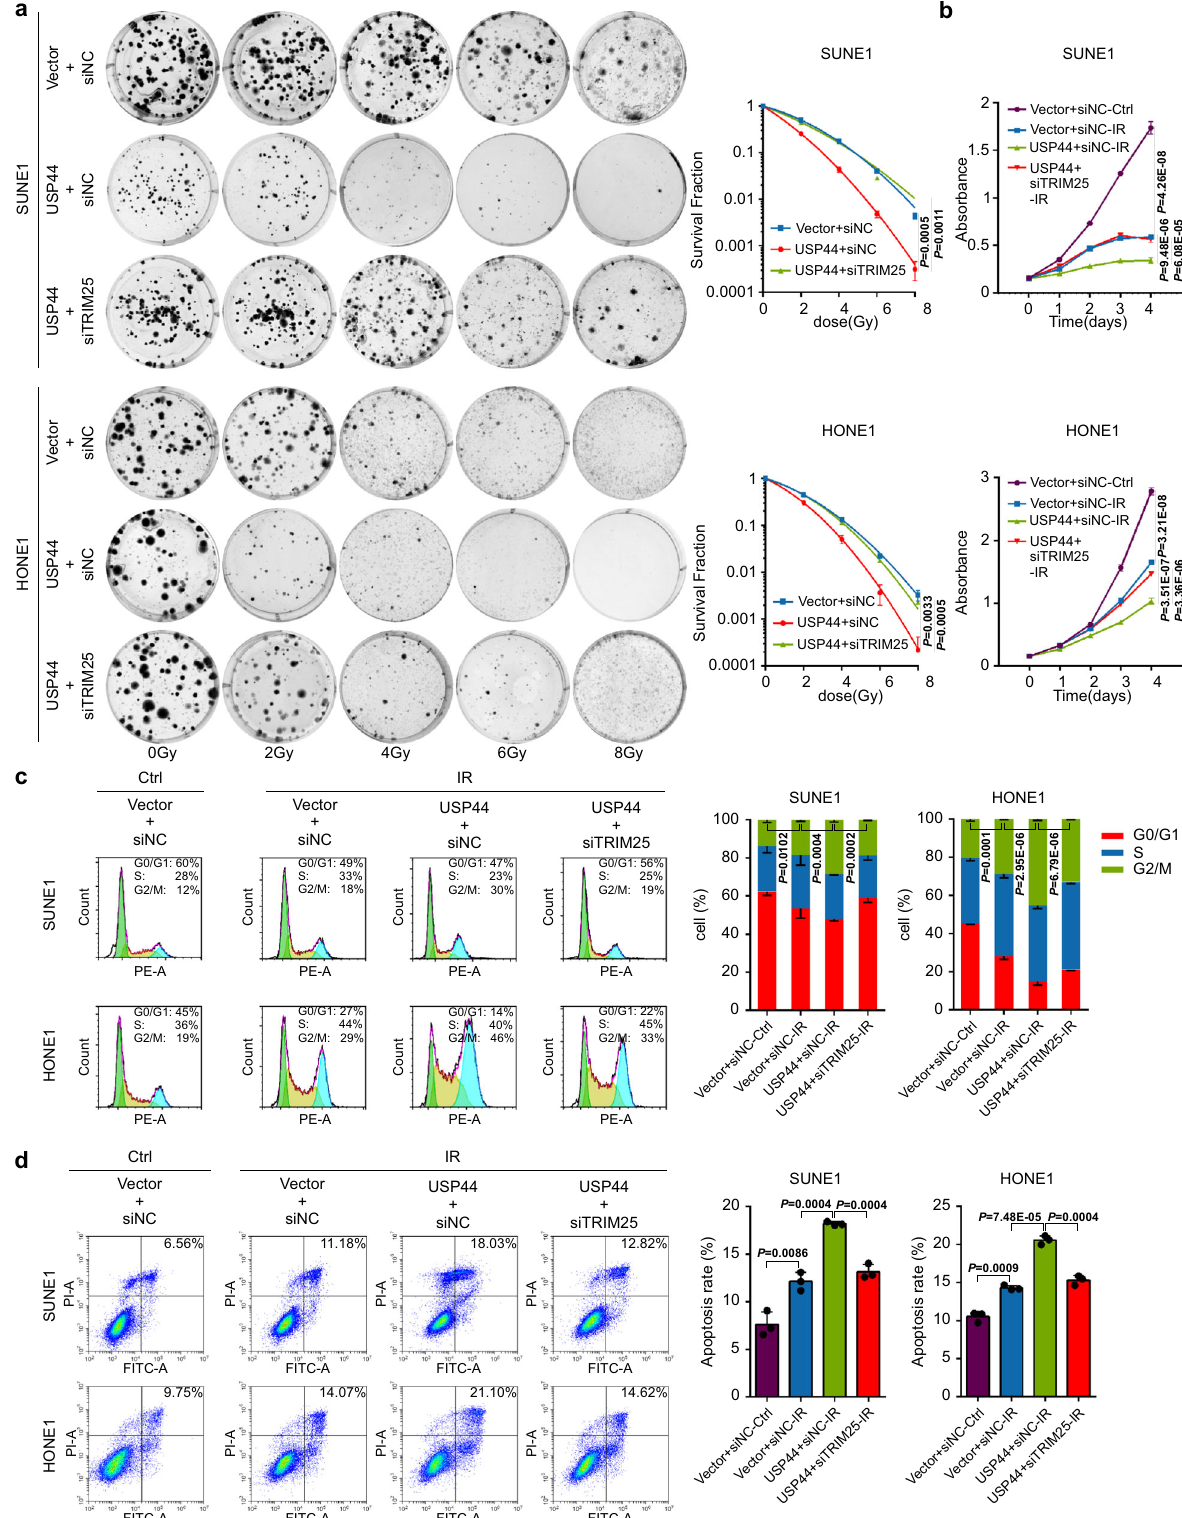
Fig. 6 Knockdown of TRIM25 reverses the radiosensitizing effect of USP44 in vitro. SUNE1 and HONE1 cells were transiently co-transfected with HA- USP44 or the empty vector plasmids plus si TRIM25 or control siRNA. a Clonogenic assays and survival fraction curve analysis ( a ) and CCK-8 assay ( b ) of transfected SUNE1 and HONE1 cells after exposure to the indicated IR dose. The absorbance at 450 nm in c is presented as the mean ± SD of n = 4 independent experiments. c , d Cell cycle distribution ( c ) and apoptosis rate ( d ) of SUNE1 and HONE1 cells with or without exposure to 6Gy-IR. The cell cycle distribution was detected at 8 h after IR and apoptosis rate was detected at 24 h after IR. Data were presented as the mean ± SD; the P values were determined using the two-tailed Student ’ s t -test; n = 3 independent experiments. Source data are provided as a Source Data fi